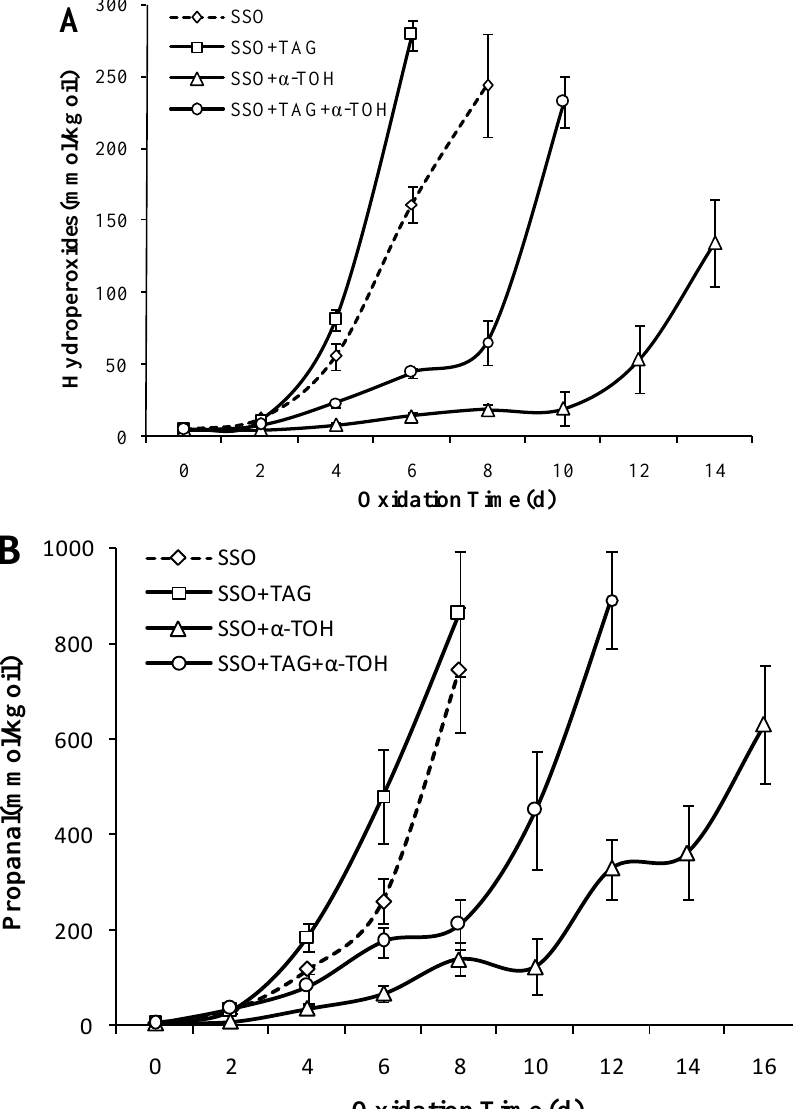
Figure 8. Effect of 1,3C-2D-TAG structured lipids on the content of POV ( A ) and propanal ( B ) of stripped soybean oil with and without α-tocopherol (50 °C).